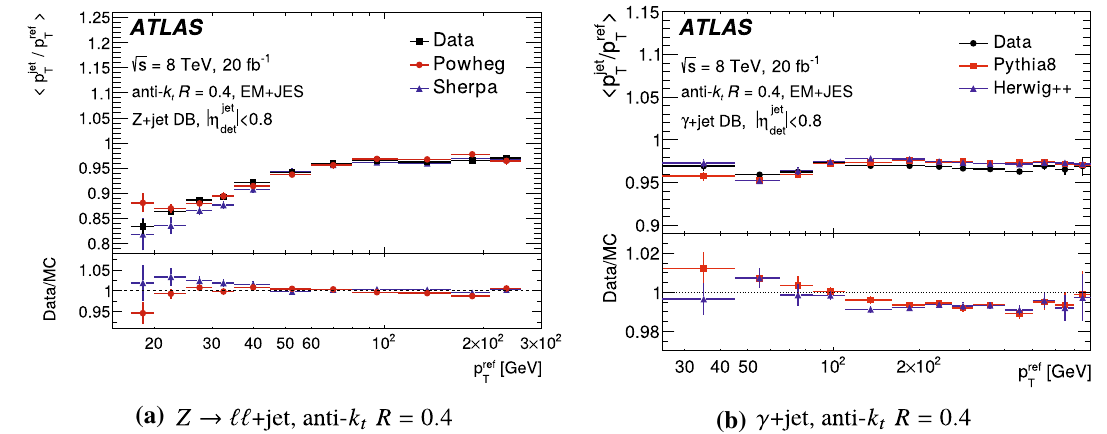
Fig. 22 R DB for anti- k t jets with R = 0 . 4 and calibrated with the EM+JES scheme from the a Z +jet and b γ +jet analyses in the data and for two MC simulations. Only statistical uncertainties are